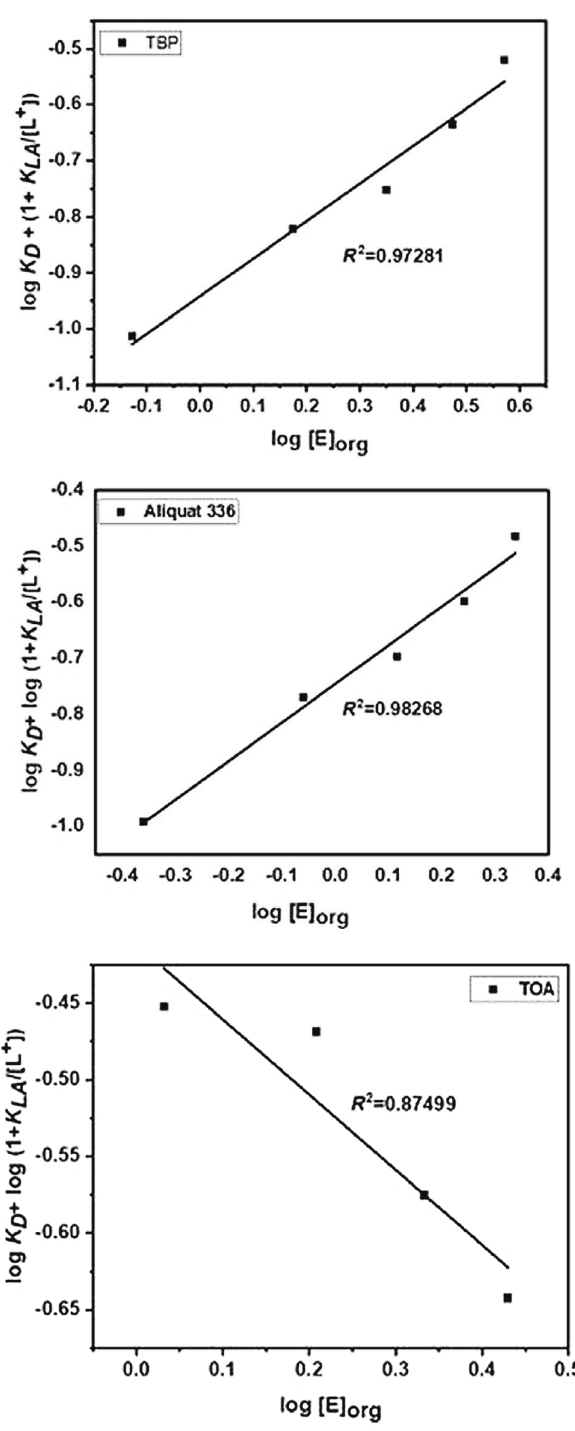
Fig. 5 – KE values evaluated for the extraction of levulinic acid using TBP, Aliquat 336, and